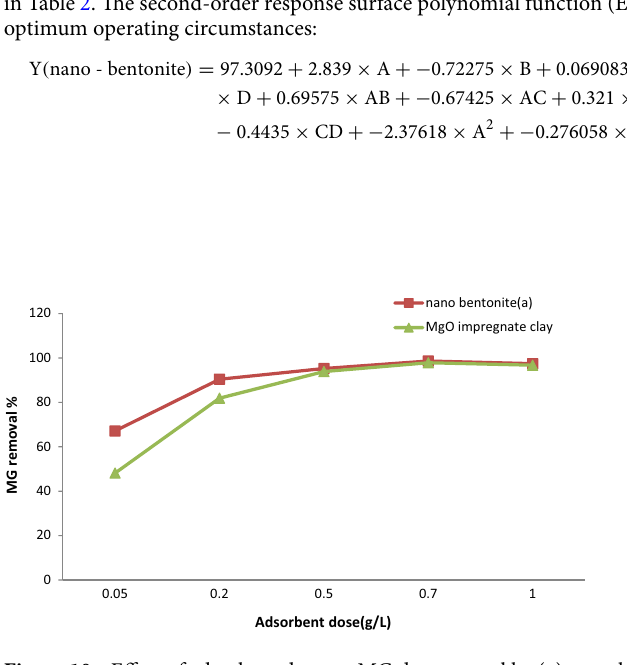
Figure 10. Effect of adsorbent dose on MG dye removal by ( a ) nano bentonite and ( b ) MgO impregnated